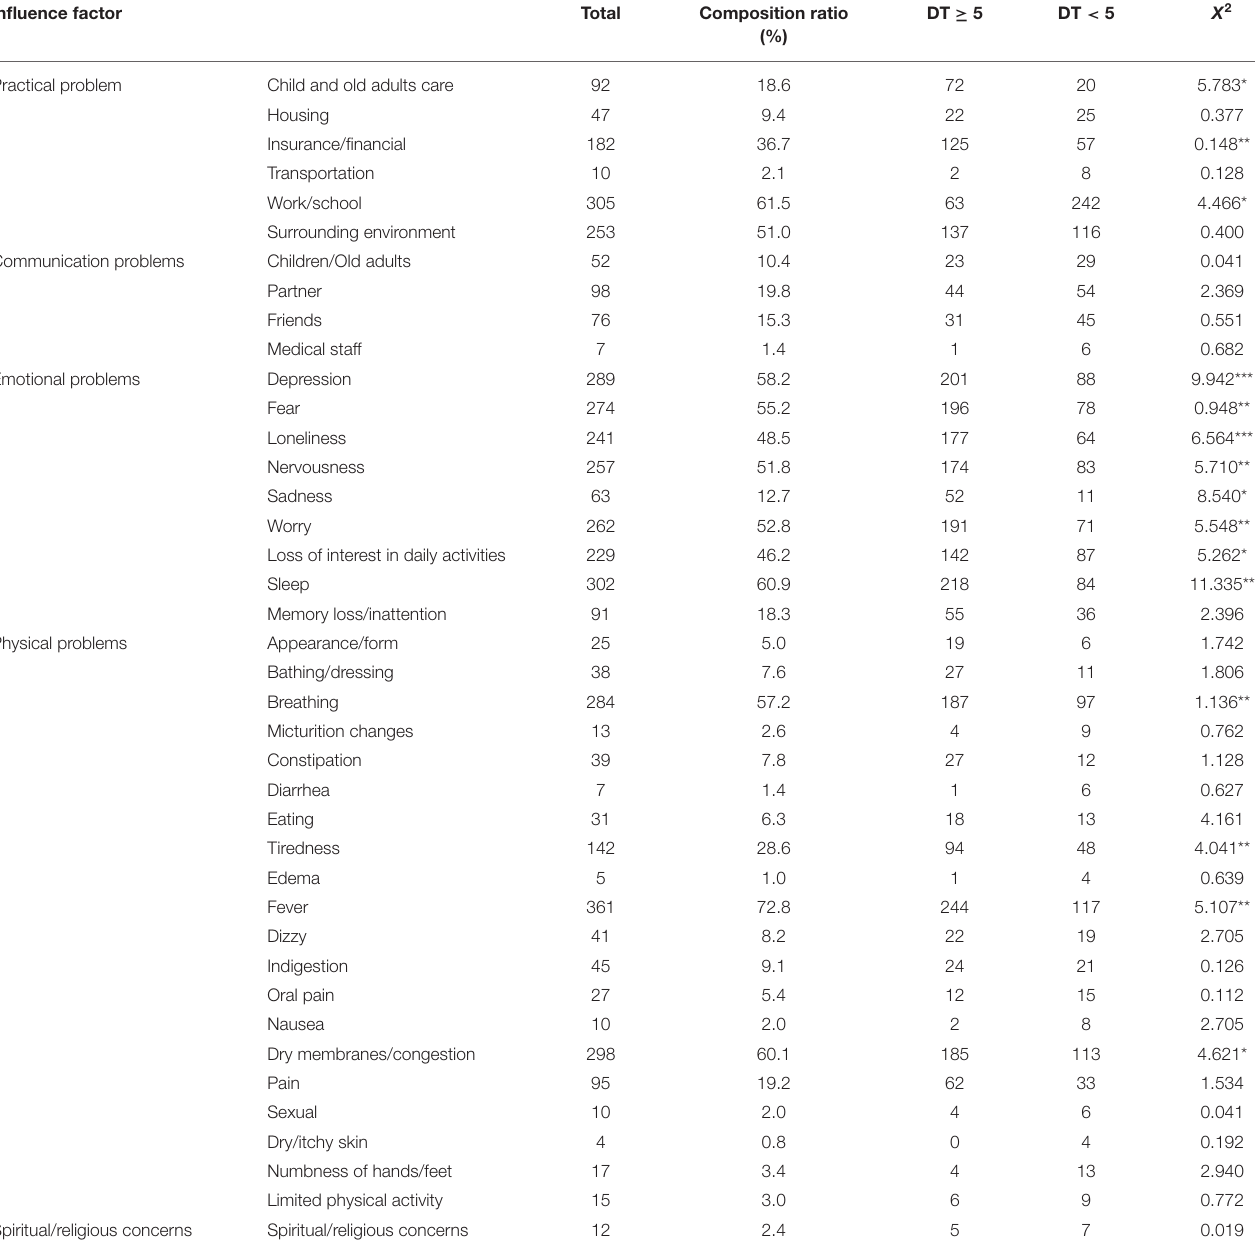
TABLE 5 | Influencing factor